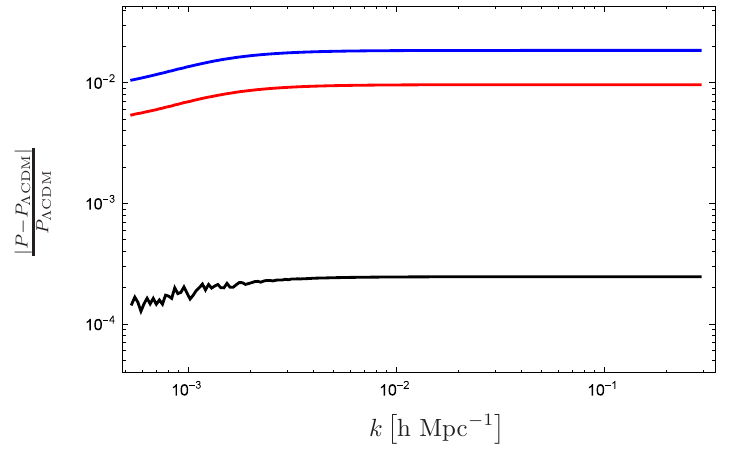
(cid:3) Figure 2. The relative deviation of the matter power spectrum of: model (i) in red; model (ii) in blue; and model (iii) in black; with regards to the predictions of Λ CDM (CDM: cold dark matter). The model that induces a Big Rip (BR) singularity shows the highest deviation, while the model that induces a Little Sibling of the Big Rip (LSBR) abrupt event presents the smallest deviation with respect to the Λ CDM